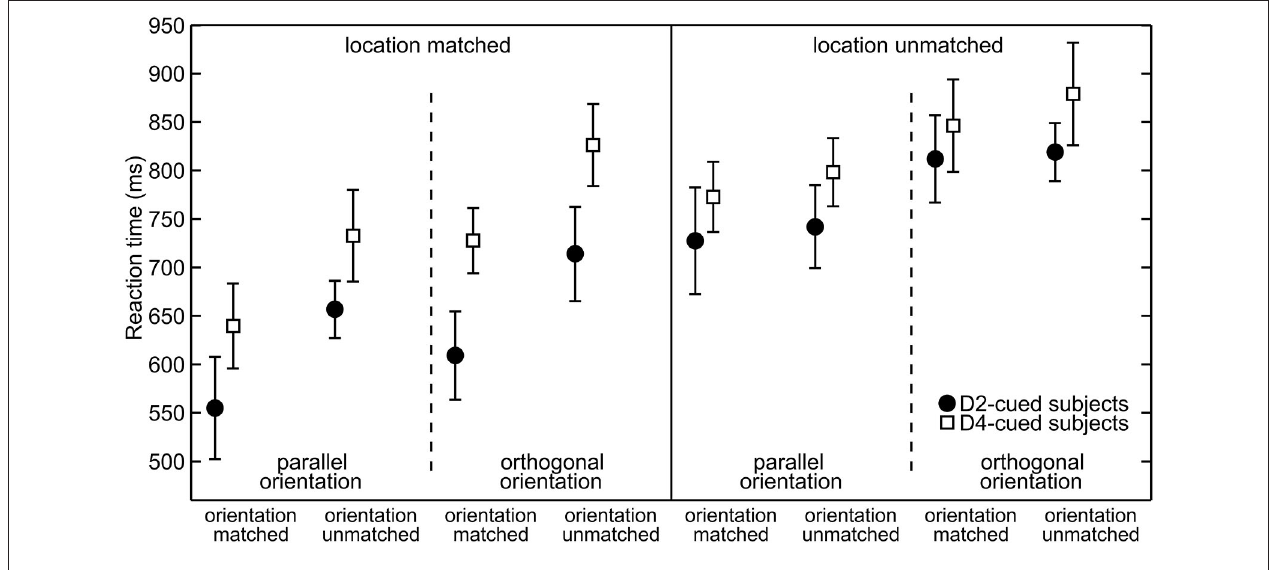
location-matched/location-unmatched targets are shown in the left/right half of the plot. Further on, these halfs are divided into parallel (left) and orthogonal (right) targets. The abscissa further sorts between orientation-matched (left) and orientation-unmatched targets